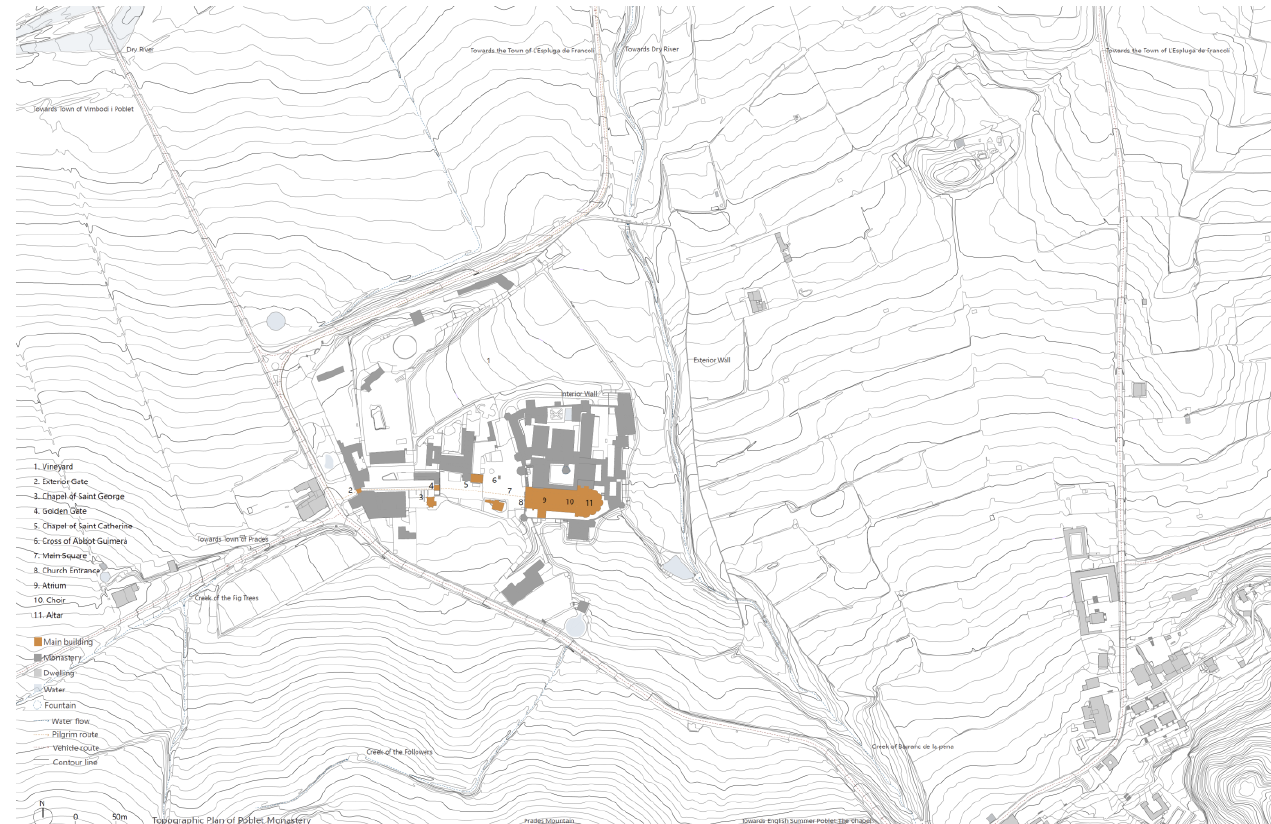
Figure 22. Topographic plan of Poblet Monastery.